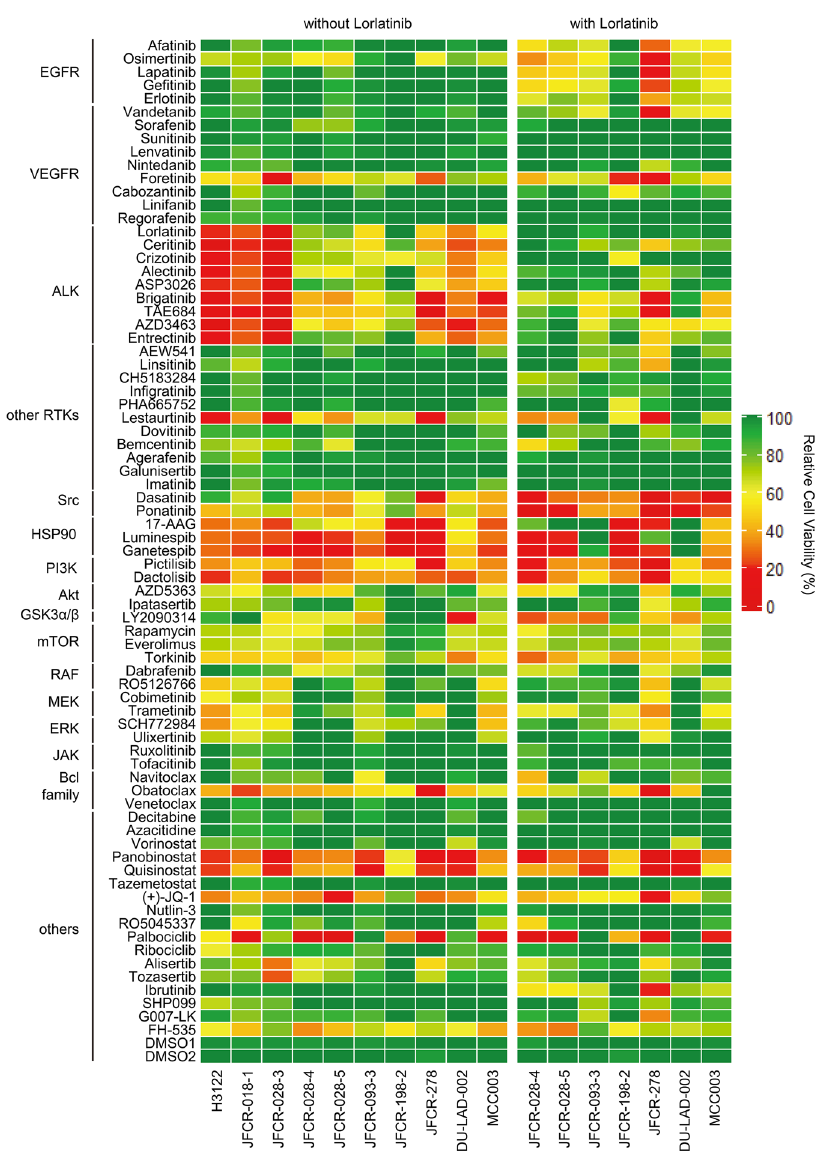
Fig. 5 Drug sensitivity pro fi le of ALK-positive cancer cell lines and PDCs using focused inhibitor library screening. Cell viability of ALK- positive cancer cell lines and PDCs treated with each inhibitor with or without 300 nM lorlatinib for 72 h was measured ( n = 2). Relative cell viability was calculated from each value divided by the DMSO